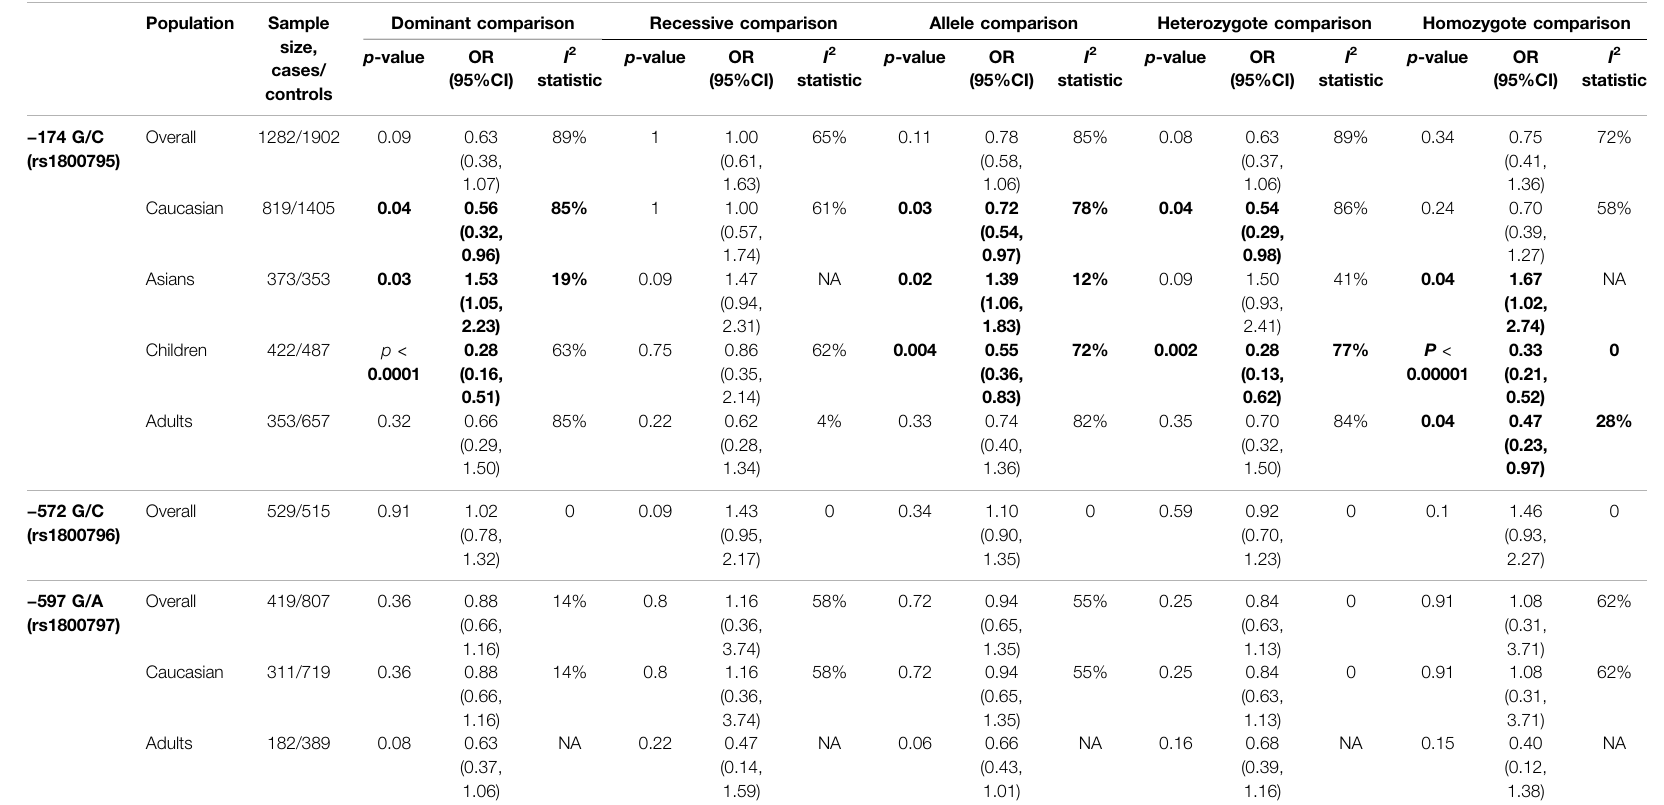
TABLE 3 | Results of pooled ORs in the meta-analysis of the association between IL-6 gene polymorphisms and overall allergic